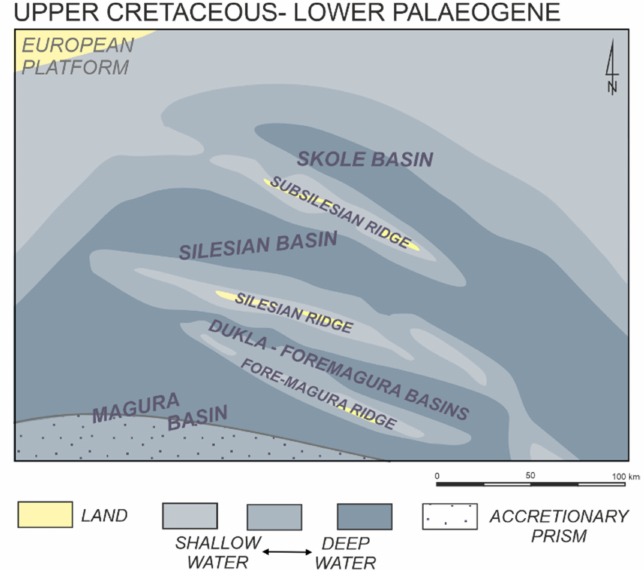
Figure 1. Paleogeographical sketch map of the Outer Carpathian basins in late Cretaceous–lower Paleogene times (after [5], modified).